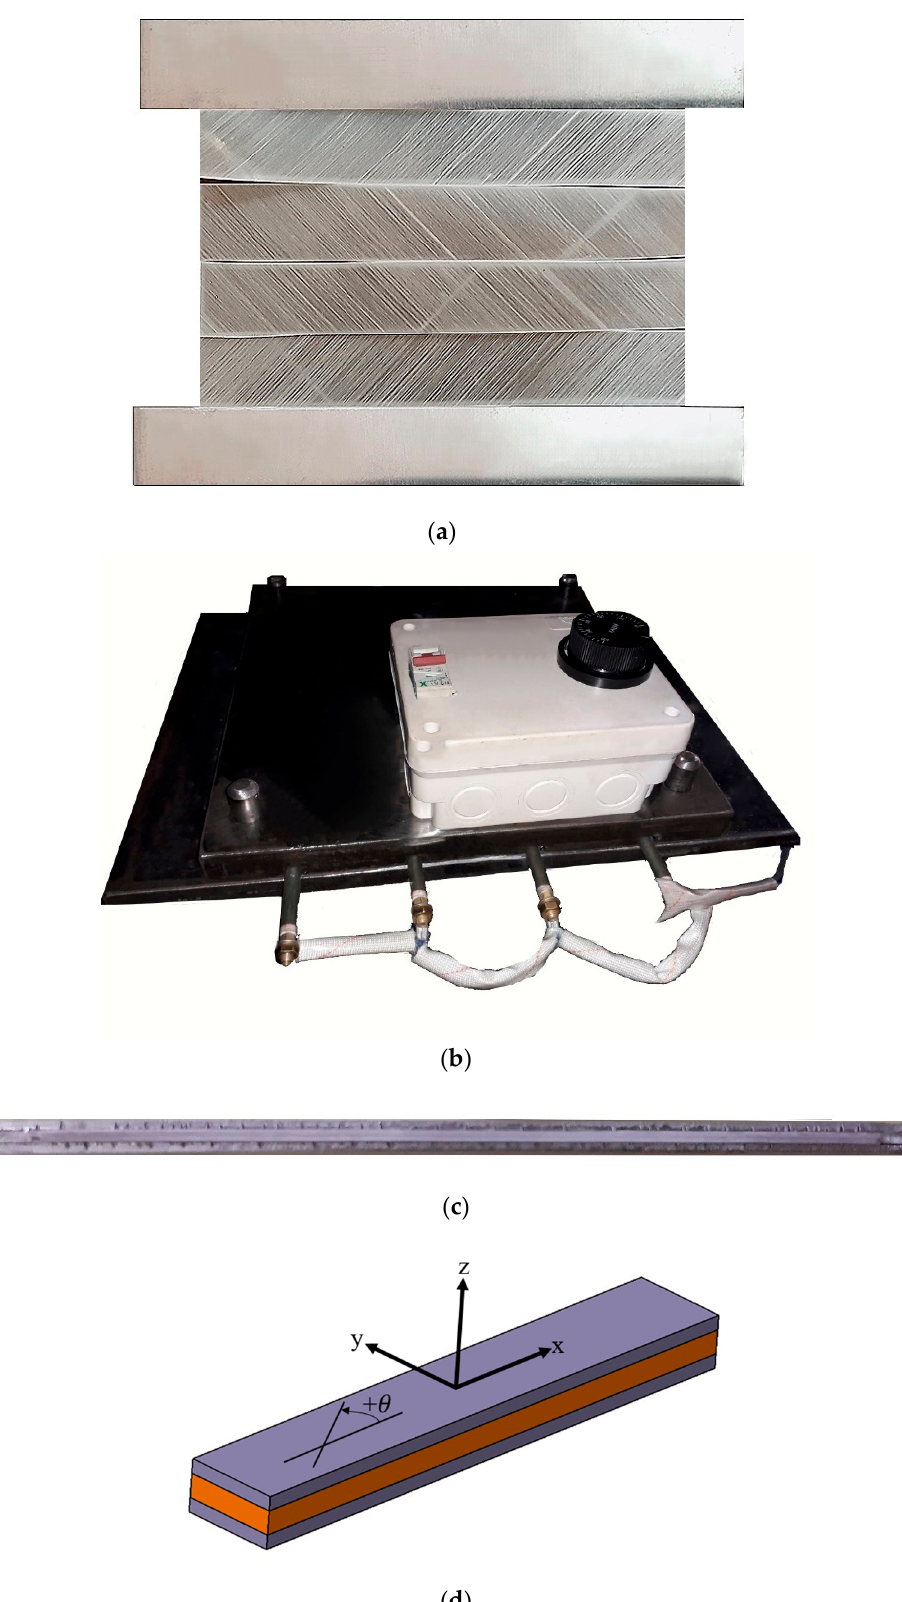
Figure 2. Preparation of FML samples; ( a ) Aluminum and GFRP layers, ( b ) Hot pressing process, ( c ) Prepared FML, ( d ) A schematic of GLARE specimen.